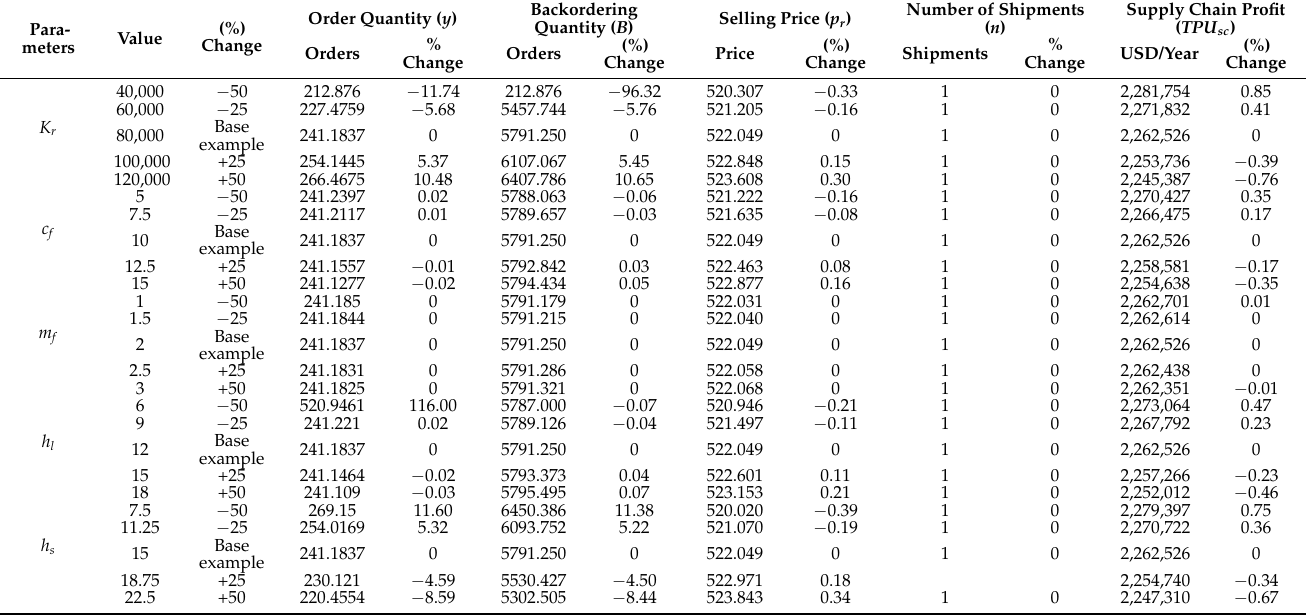
(cid:16) (cid:17) K r , c f , m f , h l , h s on the optimal